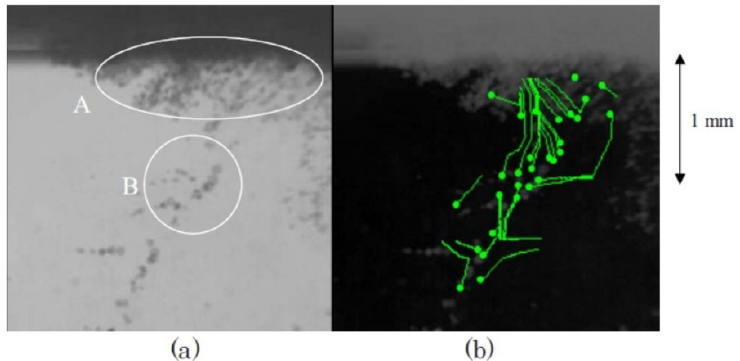
Figure 18. Cavitation bubbles under an ultrasonic horn at 29 kHz and 5 W observed by a high-speed video camera [19]. The frame ( b ) is the result of the analysis of the bubble motion. The small circles are the starting points for the analysis and the curves are the calculated streamlines of bubbles. In the frame ( a ), the bubble clouds A and B are marked by circles. Copyright 2008, with the permission from American Physical Society.